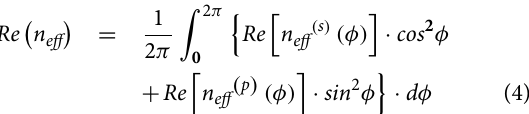
Frontiers in Physics |